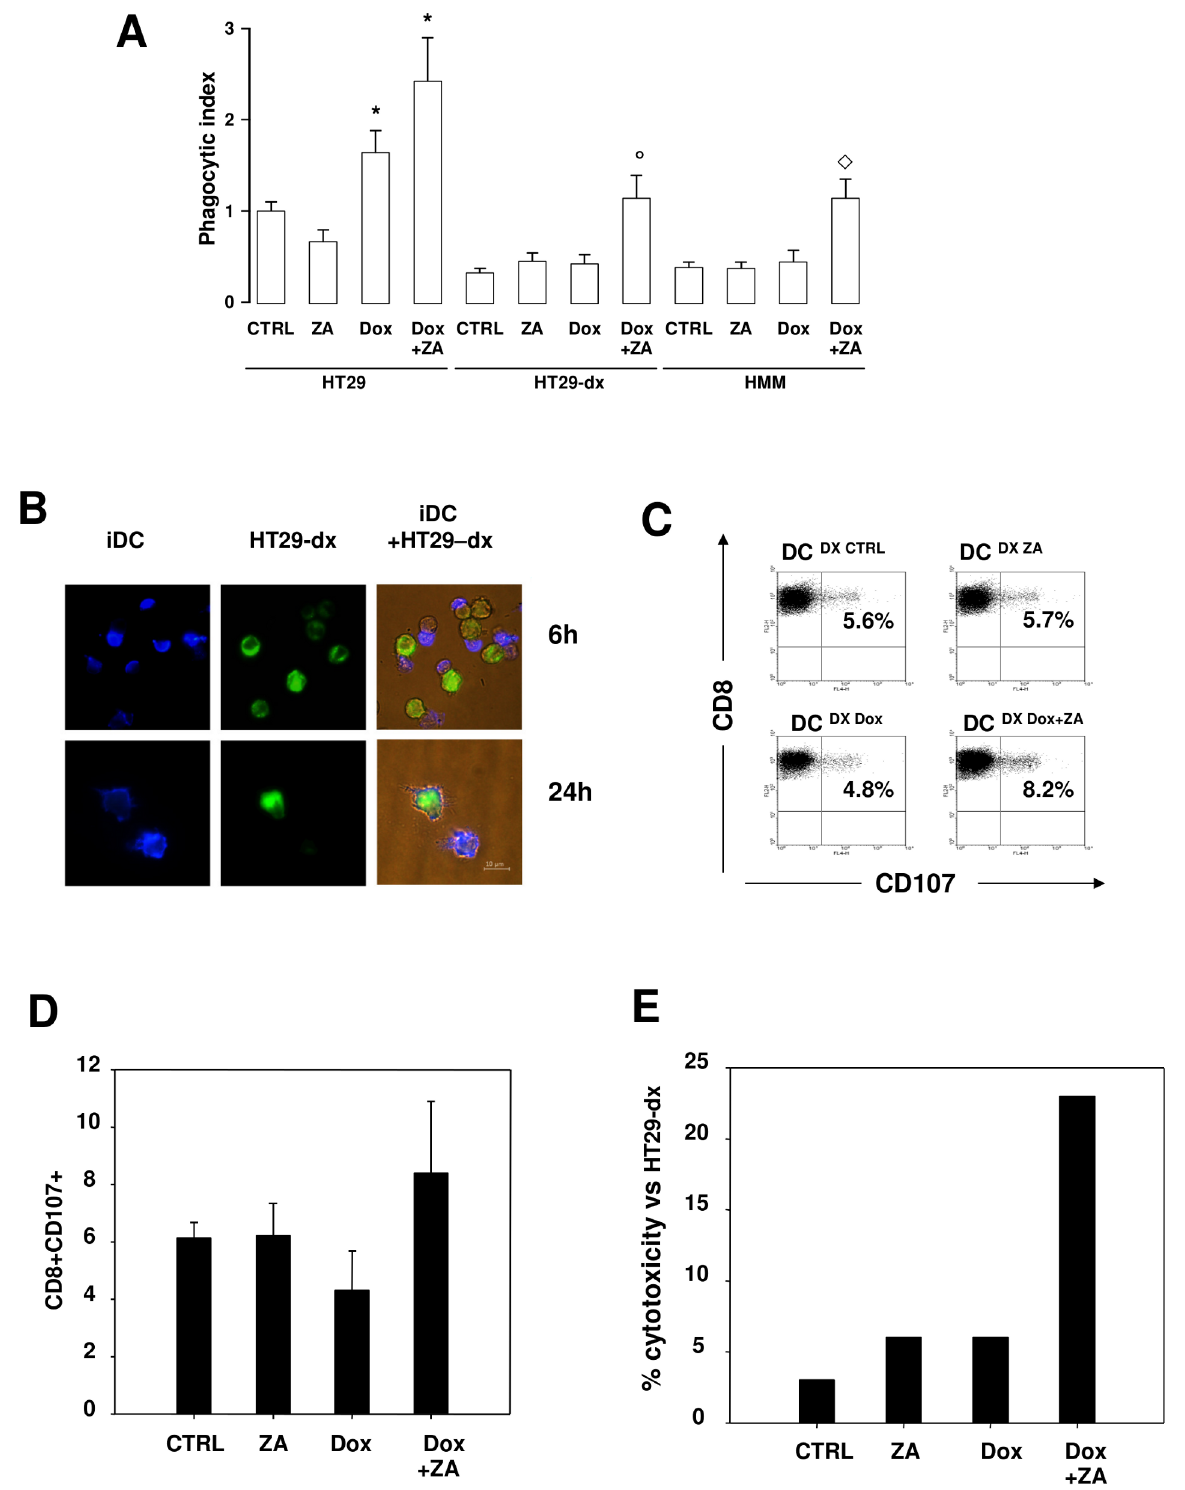
Figure 6. ZA increases the internalization of MDR + cells by autologous DCs and the subsequent activation of cytotoxic CD8 + T cells. A . DC-mediated internalization of HT29, HT29-dx, and HMM cells after incubation with ZA and/or Dox. Tumor cells were incubated for 48 h without (CTRL) or with 1 m mol/L ZA, for 24 h with 1 m mol/L Dox, for 48 h with 1 m mol/L ZA, followed by 1 m mol/L Dox for additional 24 h (ZA + Dox). Dox alone and ZA + Dox significantly increased internalization of HT29 cells (*p , 0.02). ZA + Dox increased internalization of HT29-dx ( u p , 0.005) and HMM ( e p , 0.005) cells. Results represent the mean 6 SD of 3 independent experiments. B . Fluorescence microscopy analysis of HT29-dx internalization after 6 and 24 h incubation with DCs. HT29-dx cells were incubated with ZA + Dox as reported in A. Micrographs are from one representative of 3 experiments. C . Cytotoxic activation of CD8 + T cells after 10 days incubation of purified T cells with autologous DCs pulsed with HT29-dx tumor cells,